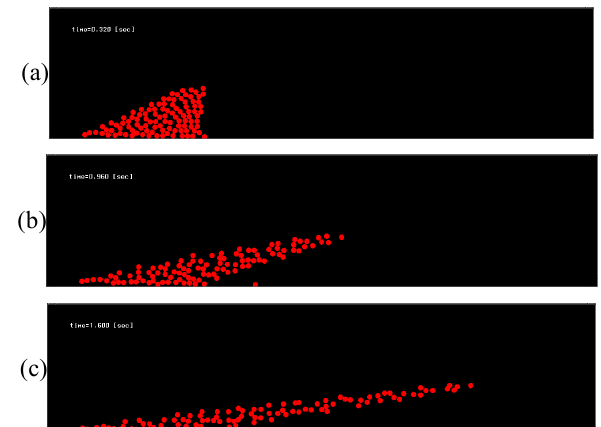
Fig. 3 The destruction process of the primary thrombus obtained from the computation for N bind = 0. (a) t = 0.32 [s]. (b) t = 0.96 [s]. (c) t = 1.60 [s]. Since the adhesive force was not induced between the particles in this case, the particles were separated individually from the original primary thrombus